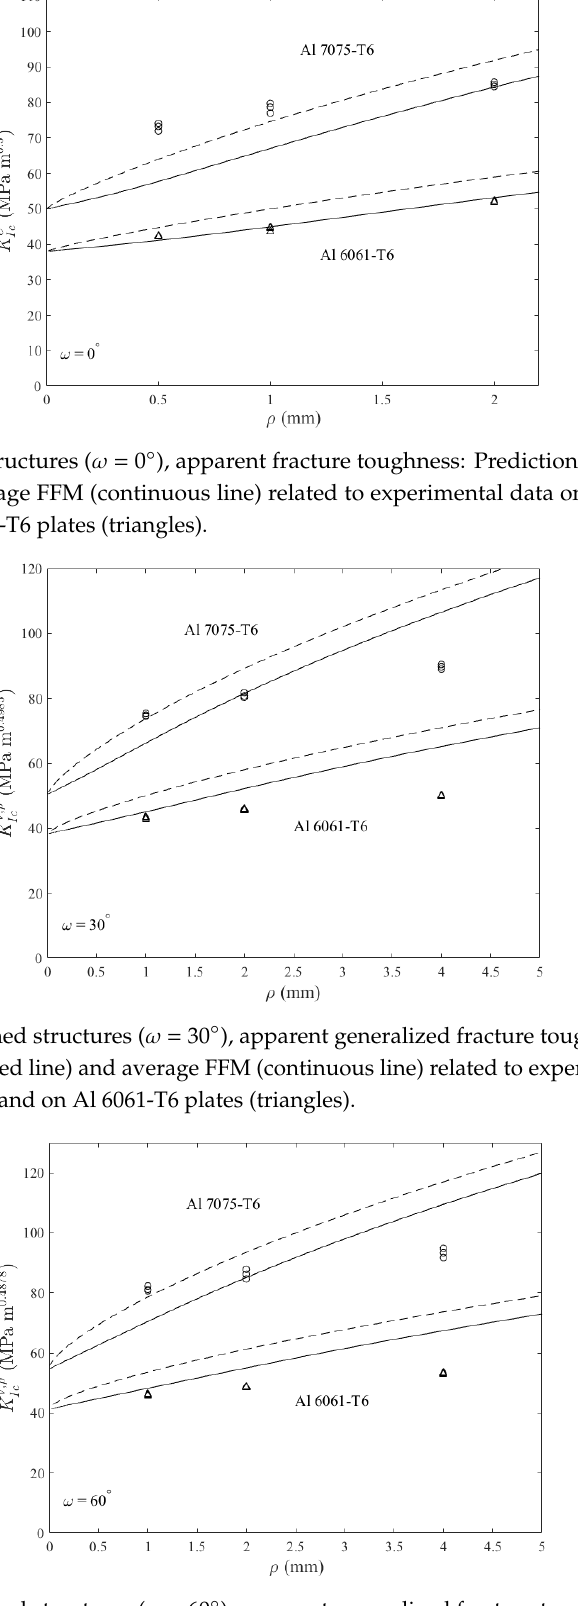
Figure 4. Blunt V-notched structures ( ω = 60 ◦ ), apparent generalized fracture toughness: Predictions by punctual FFM (dashed line) and average FFM (continuous line) related to experimental data on Al 7075-T6 plates (circles) and on Al 6061-T6 plates (triangles).